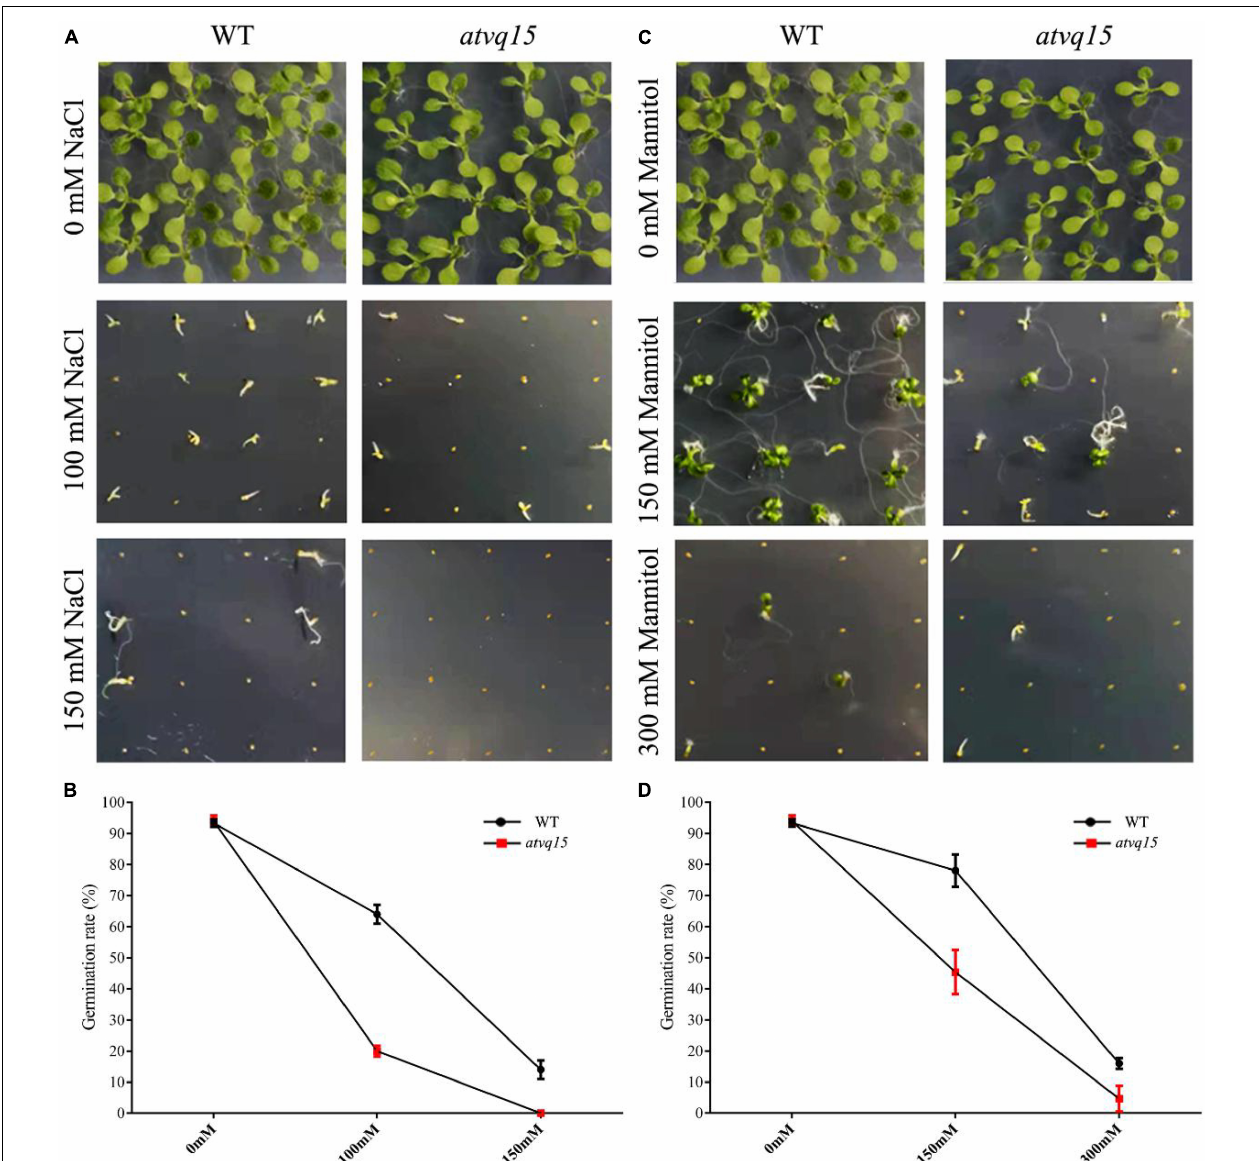
FIGURE 7 | Germination phenotypes of Arabidopsis thaliana seeds with a mutation in the gene atvq15 , a TaVQ14 homolog, under salt and drought stress. (A) Germination performance in atvq15 mutant and wild-type (WT) seeds grown on Murashige and Skoog (MS) medium containing 0, 100, or 150 mM of NaCl. (B) Rate of germination in atvq15 mutant and WT seeds. (C) Germination performance in atvq15 mutant and WT seeds grown on MS medium supplemented with 0, 150, or 300 mM of mannitol. (D) Rate of germination in atvq15 mutant and WT seeds. Relative water content, and levels of catalase, proline, superoxide dismutase, malondialdehyde, Ascorbate Peroxidase, Ascorbic acid, Glutathion Reductases, L-Glutathione, and L-Glutathione oxidized in atvq14 and WT plants after salt treatment. Relative water content, and levels of catalase, proline, superoxide dismutase, malondialdehyde, Ascorbate Peroxidase, Ascorbic acid, Glutathion Reductases, L-Glutathione, and L-Glutathione oxidized in atvq14 and WT plants after drought